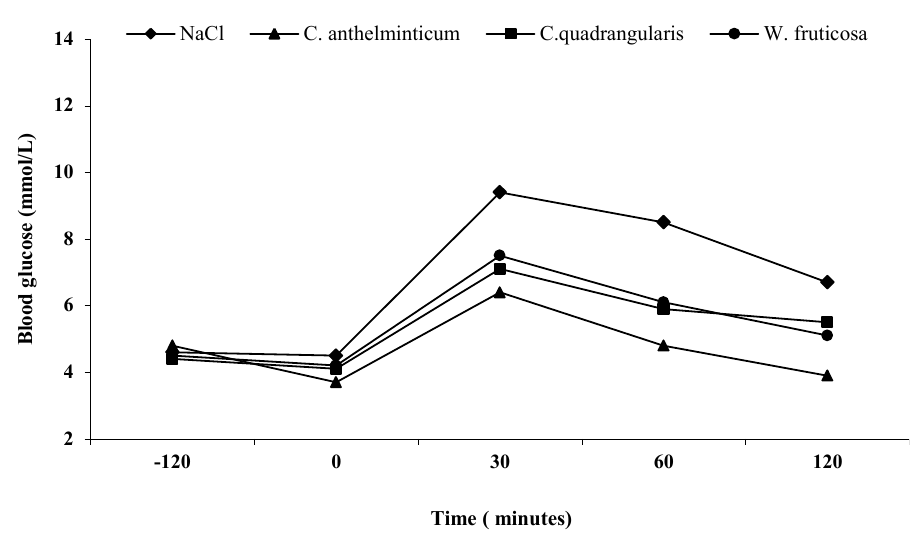
Figure 1 . Intra-peritoneal glucose tolerance test on C. anthelminticum , Cissus quadrangularis , and Woodfordia fruticosa Kurz extracts in normal fasted rats with glucose- induced hyperglycemia. Data are mean ± SE. n = 6 for each group. ( P <0.001) for the three extracts when compared with normal control ( P <0.01)